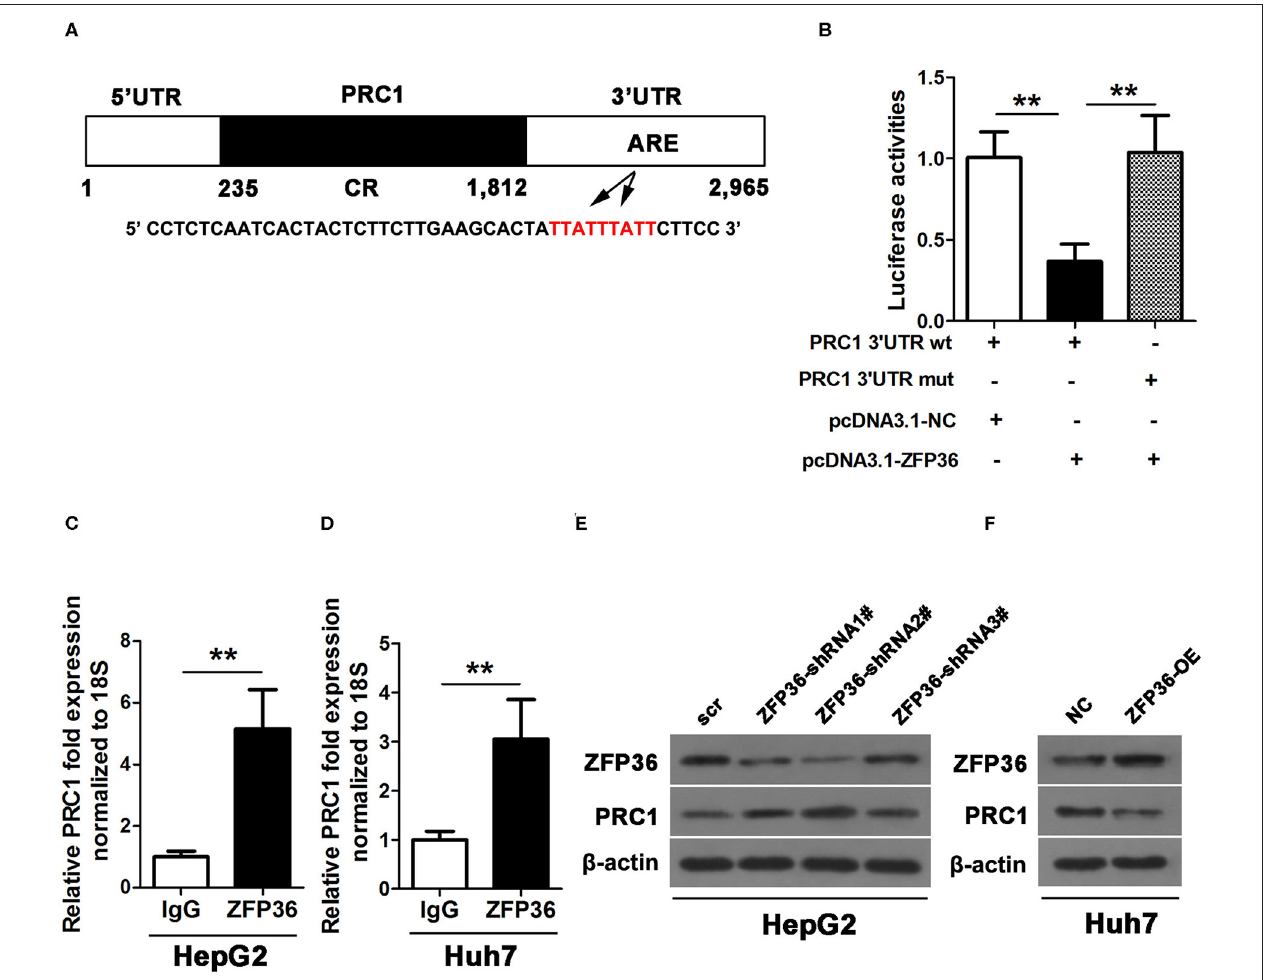
FIGURE 7 | ZFP36 binds to the PRC1 3 ′ UTR. (A) Schematic diagram of the 3 ′ UTR sequence of PRC1. CR, coding region; UTR, untranslated region, and ARE elements. (B) A luciferase reporter plasmid containing wild-type or mutant PRC1 was co-transfected into 293 cells with pcDNNA3.1-ZFP36 or a negative control (NC). Luciferase activity was determined at 48h after transfection using the dual-luciferase assay and shown as the relative luciferase activity normalized to renilla activity. (C,D) Association of endogenous ZFP36 with endogenous PRC1 mRNA. After IP of RNA–protein complexes from cell lysates using either anti-ZFP36 antibody or control IgG, RNA was isolated and used in RT-PCR reactions. PRC1 levels of mRNAs in ZFP36 IP or IgG IP materials as measured by qPCR in Huh7 and HepG2 cells. (E,F) Knockdown of ZFP36 (ZFP36 shRNA1# − 3#) in HepG2 cells and the overexpression of ZFP36 in Huh7 cells, the protein expression of ZFP36 and PRC1 were detected by western blot analysis. ** p <